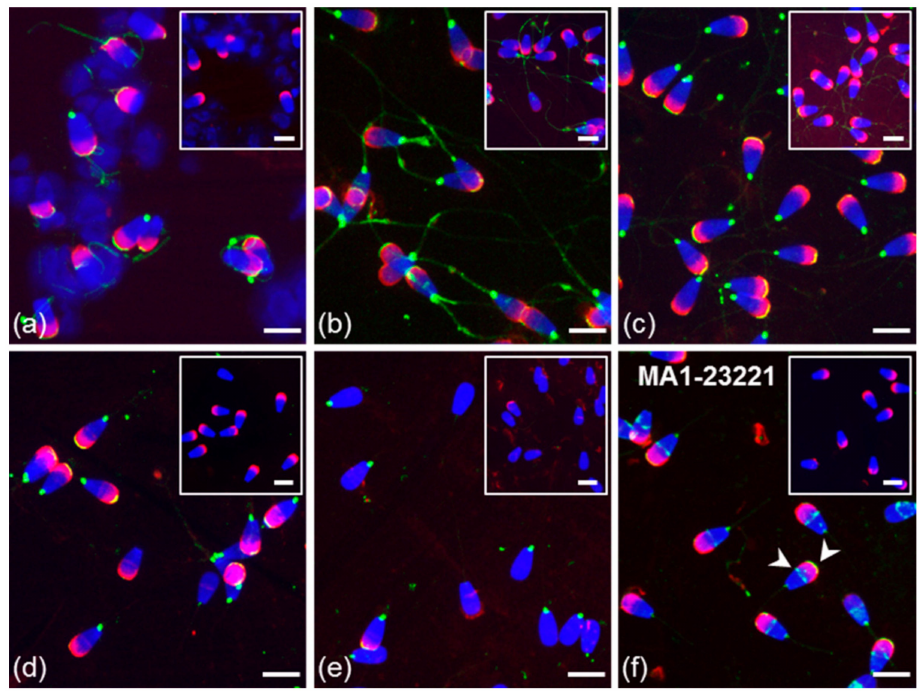
Figure 4. Localization of ESR2 in bull spermatozoa. Spermatozoa from testes ( a ) and the cauda epididymis ( b ); freshly ejaculated sperm ( c , f ); spermatozoa after in vitro capacitation ( d ); sperm after acrosome reaction ( e ). Spermatozoa were treated with polyclonal antibody H-150 (green) or rabbit IgG isotype control ( a – e ) or with monoclonal antibody MA1-23221 or mouse IgG2 isotype control ( f ). Arrows indicate the ESR2 detection in the apical and equatorial segment of sperm head with the MA1-2321 antibody ( f ). Nuclear DNA was stained by DAPI (blue), and spermatozoa acrosomes were labeled by PNA lectin (red). Controls are shown in the top right corner of the figures. Scale bar represents 10 µ